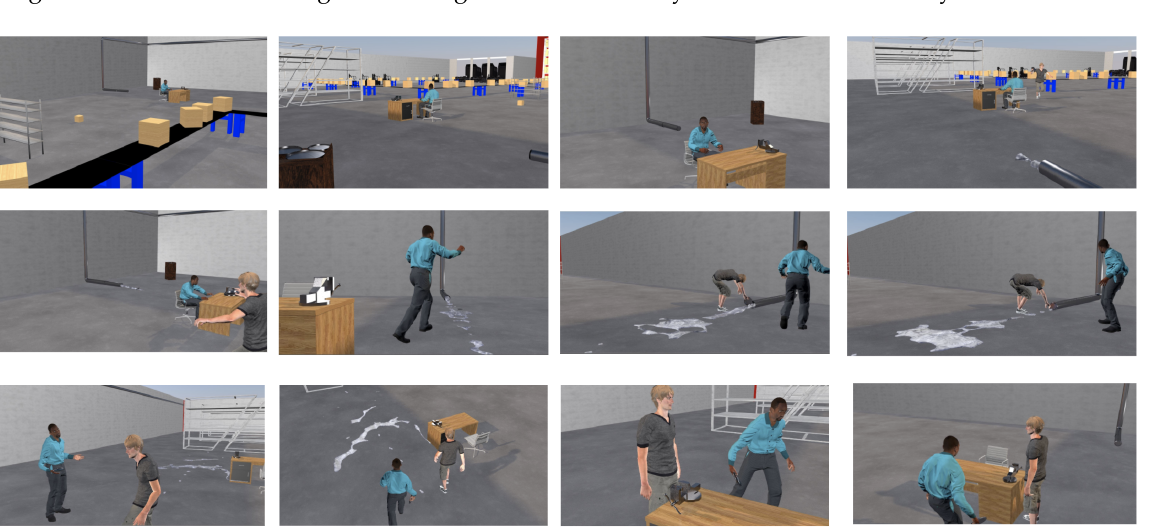
Figure 2. Storyboard of our immersive virtual storytelling training